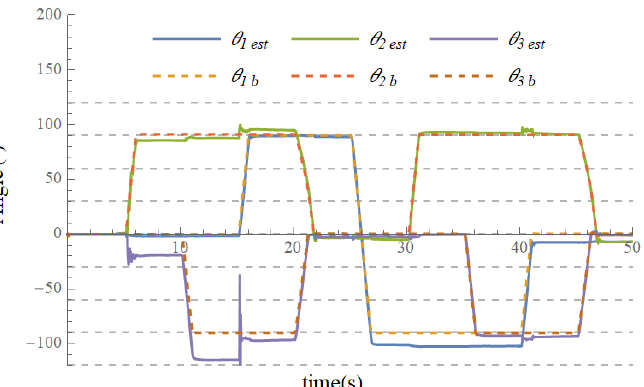
Figure 16. Evolution of estimates of the joints’ angles when testing the joint model using gyro- scope